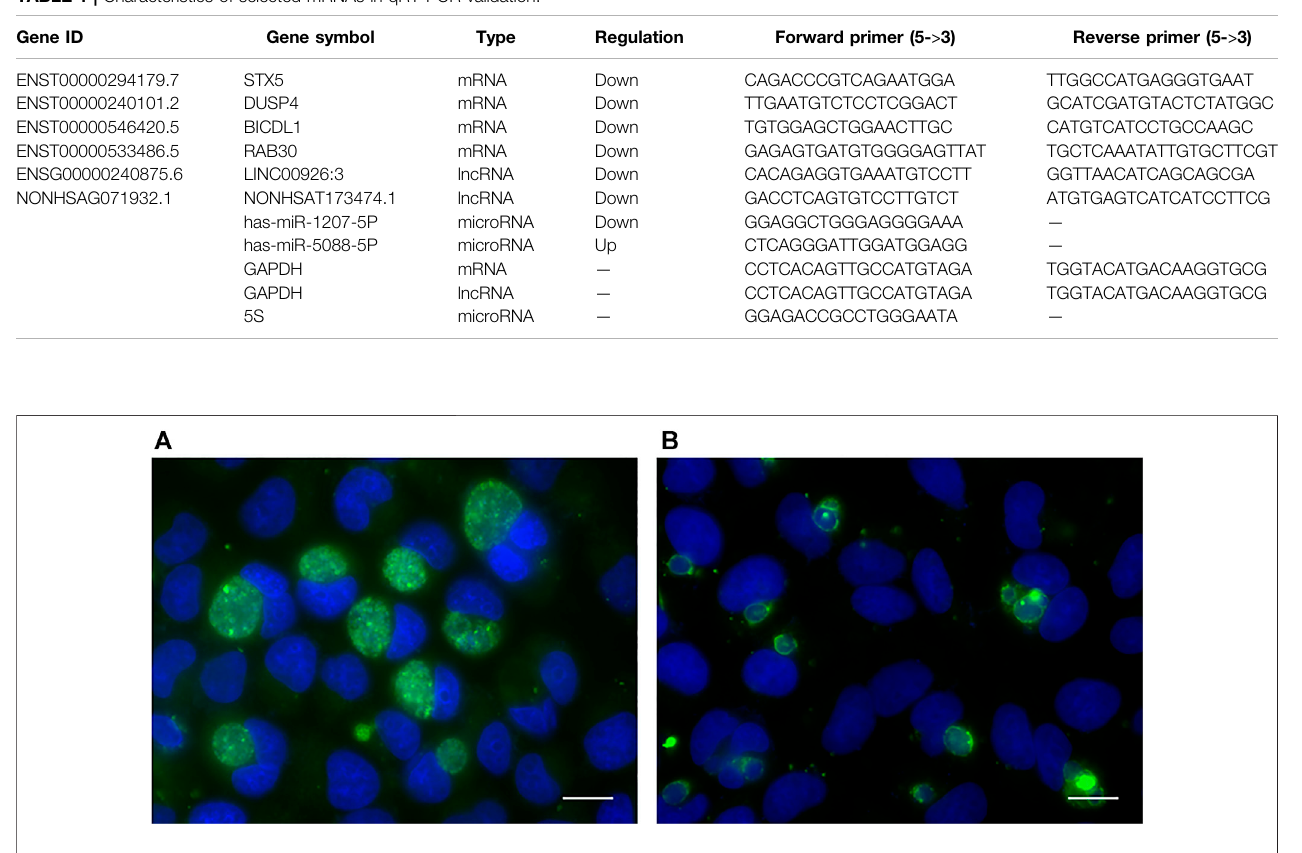
FIGURE 1 | Immuno fl uorescence analysis of acute (A) and persistent (B) chlamydial infection in HeLa cell. The chlamydial inclusions were stained with goat polyclonal to Chlamydia trachomatis MOMP coupled to FITC (green). DNA was stained with DAPI (blue). Scale bar = 50 μ